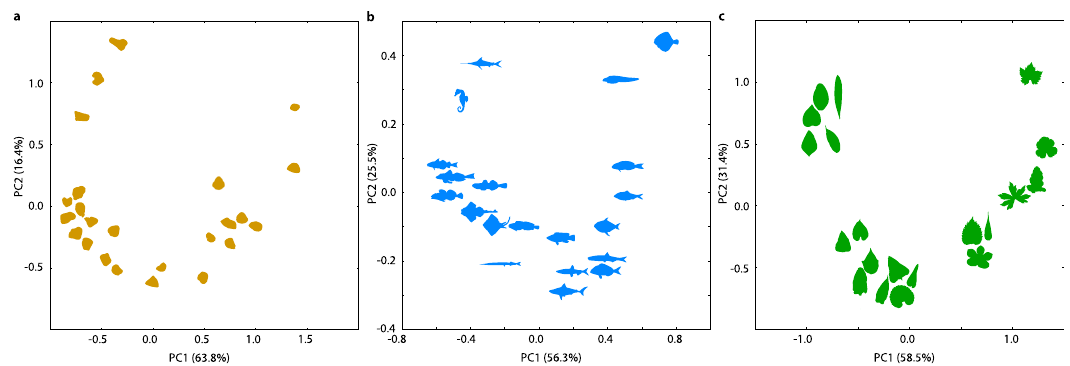
Fig. 3 Comparison of shapes from different domains based on their visibility graphs. The distances between visibility graphs based on the spectra of their Laplacians can be used in multivariate analyses and visualizations to distinguish different groups of similar shapes. We show the principal component analyses of shapes from three different domains: a sand grains, b fi sh shapes, and c leaf shapes 13,31,32 . Source data are provided as a Source Data